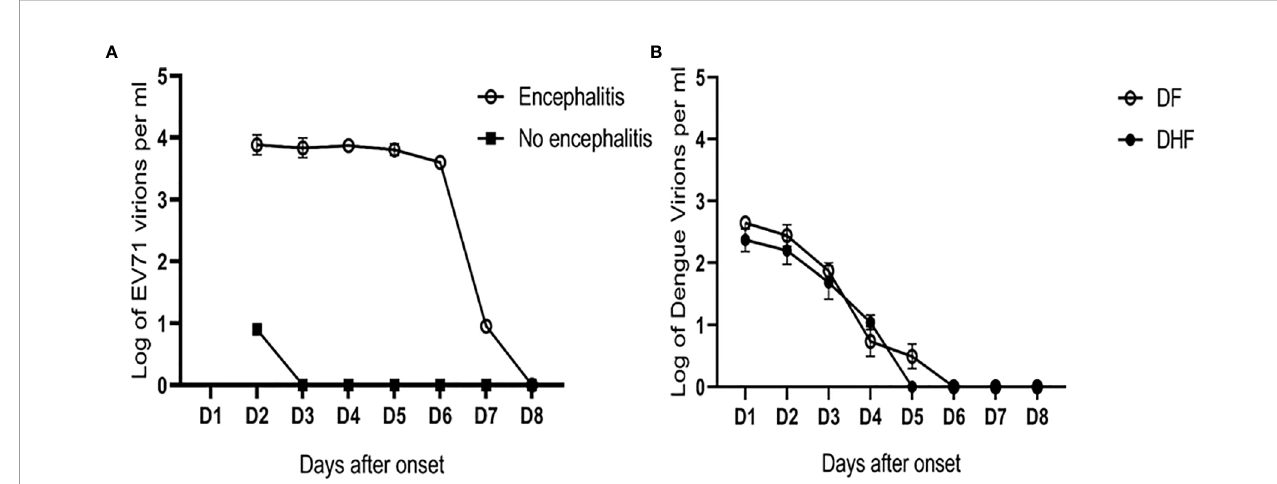
FIGURE 2 | Different patterns of viral load in EV71 and dengue infections. (A) The blood viral loads in EV71 encephalitis patients were signi fi cantly higher than those with no encephalitis (data derived from 12 pairs of case-control samples). Based on the unit of one milliliter blood (ml), the limit of detection (LOD) is 9 copies/ml in patients with EV71. In contrast, (B) the blood viral loads in patients with dengue hemorrhagic fever (DHF) were not signi fi cantly different from those in dengue fever (DF). The LOD is 3 copies/ml in patients with dengue infection (the representative graph is derived from the publication (Chen, et al. FEMS Immunol Med Microbiol. 2005;44